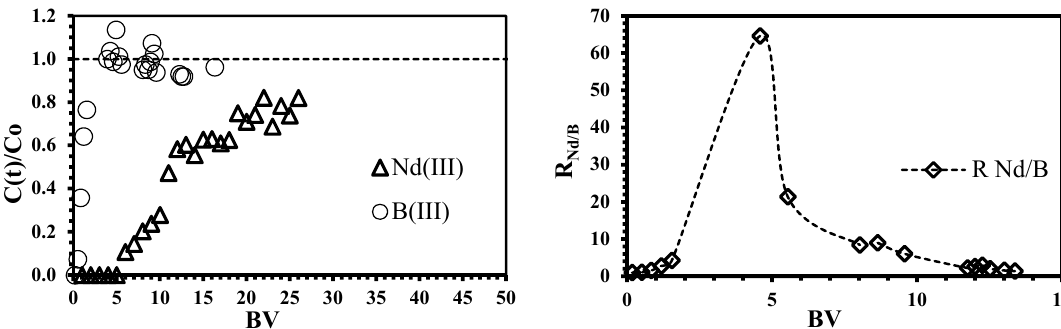
Figure 8. Simultaneous sorption of neodymium and boron using ChiFer(III) material as fixed-packed sorbent. ( Left side : Breakthrough curves as a function of Bed-volume (BV), dashed line: overshooting guide line; right side : Separation coefficient R Nd/B as a function of BV; dashed line: experimental trend; T: 20 ◦ C; internal diameter of the column, Ø: 1.8 cm; bed depth: 23 cm; flow rate: 0.01 L · h − 1 ; pH: 4; C 0 : 0.1 mmol · L − 1 ).